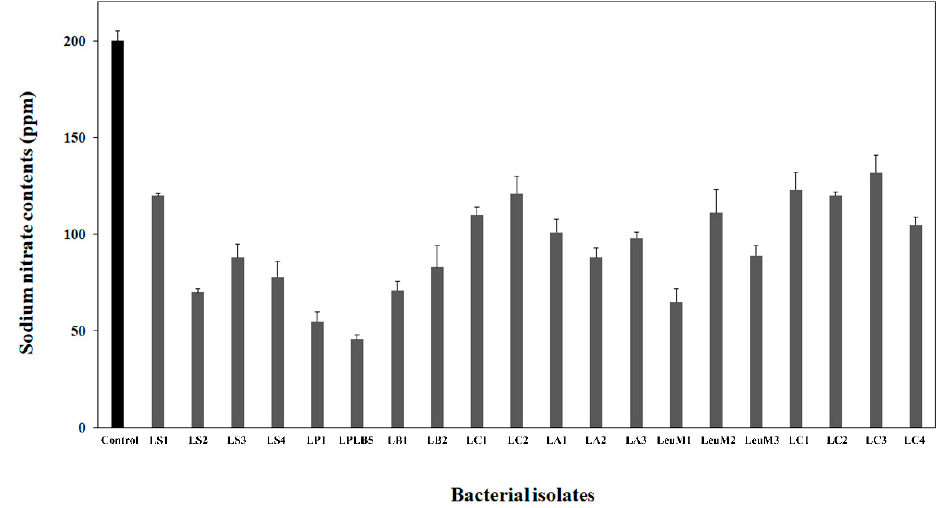
Figure 1. Nitrate reduction in the culture supernatant of bacterial isolates from kimchi. Nitrate contents